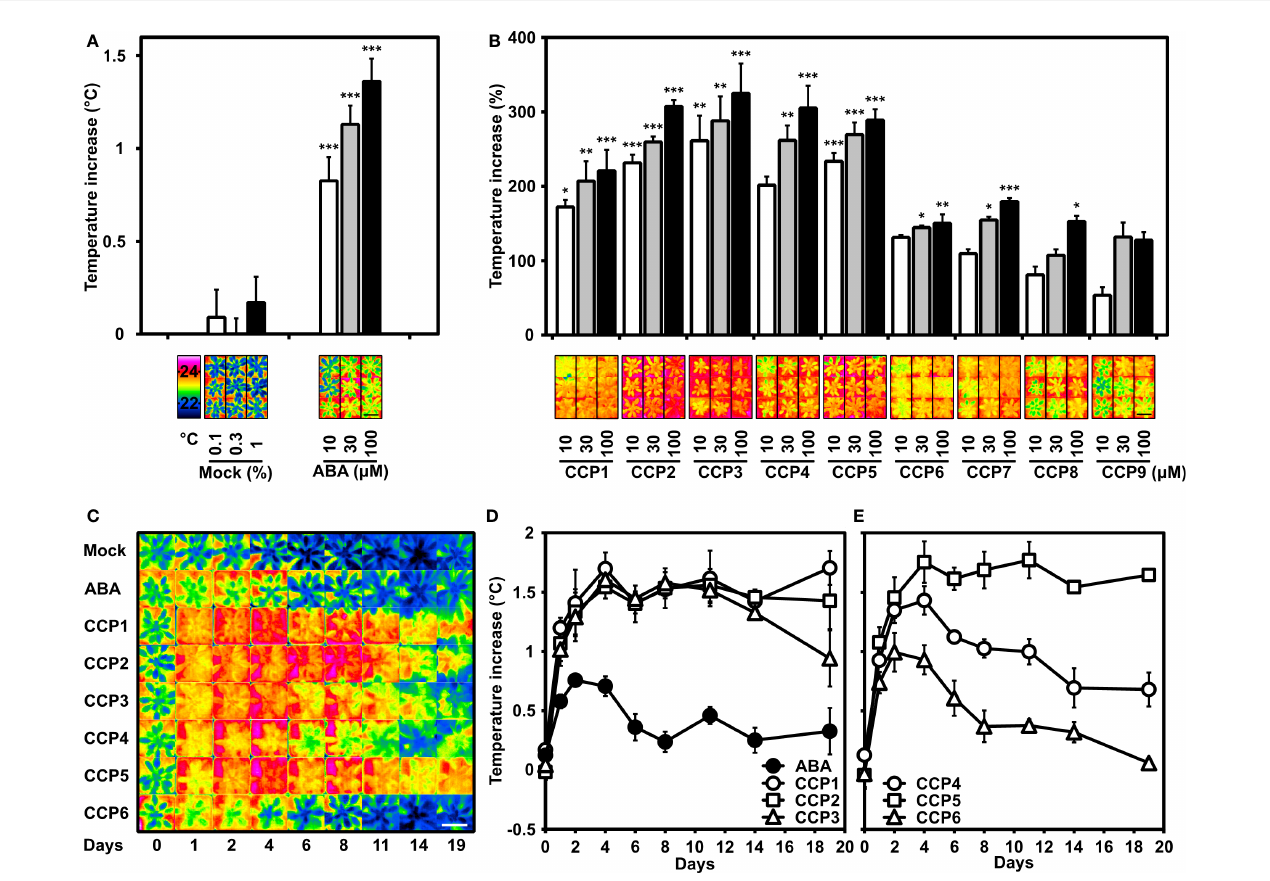
FIGURE 5 Potency of CCPs superior to ABA for regulating transpiration of Arabidopsis plants. Transpiration is indirectly assessed by determining the leaf temperatures of Arabidopsis rosettes controlled by leaf transpiration and affected by foliar ABA and ABA agonist administration. (A) ABA administration (10, 30, and 100 m M) was presented by spraying an aqueous solution containing the ligand and up to 1% DMSO and 0.01% (v/v) Tween 20 as solvent and surfactant, respectively. The increase in leaf temperature compared to mock-treated plants (0.1, 0.3, and 1% DMSO) and plants without treatment (set to zero) is presented. The leaf temperature difference was recorded one day after application and averaged from fi ve independent experiments. The leaf temperature of non-treated plants was 21.9 ± 0.1°C, 22.2 ± 0.1°C, 21.4 ± 0.04°C, 21.0 ± 0.04°C, and 21.7 ± 0.1°C. Representative thermal images of mock-treated and ABA-treated plants are shown in false-colour in the lower panel together with the colour-temperature code. (B) The leaf temperature increase by CCP application (10, 30, and 100 m M) is expressed relative to the temperature increase achieved with 10 m M ABA (conditions as in A). The temperature increase at 10 m M ABA was 0.9 ± 0.1°C for CCP1, 0.7 ± 0.11°C for CCP2 and CCP5, 0.4 ± 0.15°C for CCP3 and CCP4, 1.1 ± 0.12°C for CCP6, and 1.0 ± 0.16°C for CCP7 to CCP9, respectively, and were set to 100% for comparison. Representative thermal images of CCPs-treated plants are shown in the lower panel. (A, B) 35-day-old plants were grown under short-day conditions. The white, grey, and black columns represent the data of plants either exposed to mock solvent 0.1, 0.3, 1% DMSO, or to 10, 30, 100 m M ligand solution, respectively. (C – E) The superior activity of selected CCPs and longer lasting ef fi cacy than ABA is revealed by time-course experiments with a single ligand administration (100 µM; day = 0). (C) Representative thermal images of plants and (D, E) leaf temperature increases of Arabidopsis plants were recorded before treatment (day 0) and for 19 days (as indicated in C-E) after ligand administration and were compared to the mock-treated plants (22.2 ± 0.02°C; 21.4 ± 0.04°C; 22.1 ± 0.05°C; 21.9 ± 0.02°C; 22.0 ± 0.09; 21.7 ± 0.05; 21.7 ± 0.05; 21.6 ± 0.06; 20.8 ± 0.19°C). The false colour code is as shown in A). (D,E) Data points for plants treated with ABA and CCP1 to CCP6 are shown by symbols as indicated in the fi gures. (A – E) Single plants were cultivated in pots at short-day conditions under well-watered conditions. After treatment, the plants were randomized in the tray position. Thermal pictures of the tray with 24 pots were taken and the false-colour photograph of individual plants sorted in groups of common treatment as shown. n = 5 biological replicates per experiment, mean ± SEM. The scale bars indicate 5 cm. (A) ***P < 0.001 (one-way ANOVA) compared to mock treatment. (B) *P < 0.05, **P < 0.01, ***P < 0.001 (one-way ANOVA) compared to plants treated with 10 m M